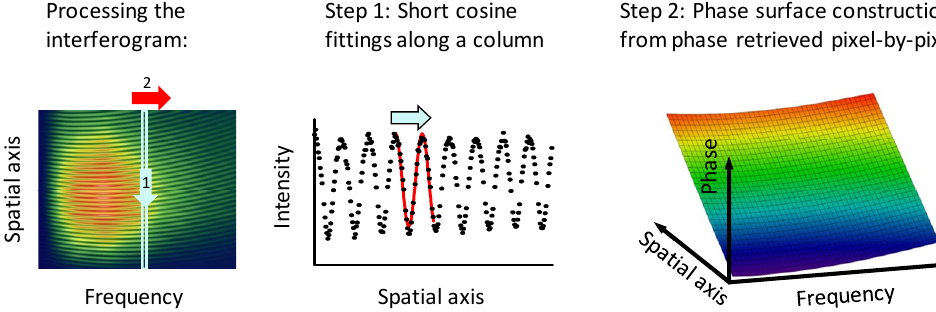
Figure 11. Steps of the phase extraction from the